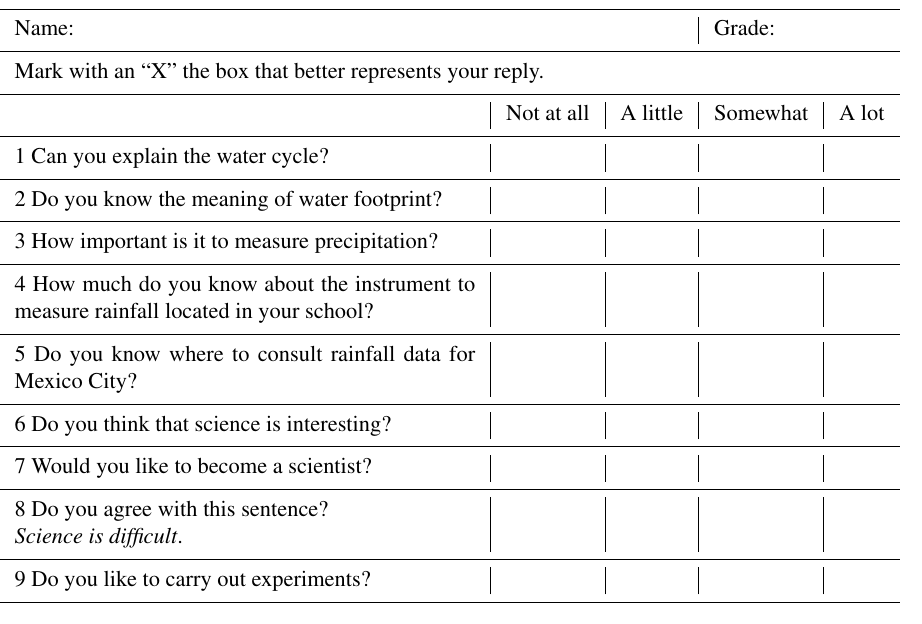
Table 2. Diagnostic evaluation questionnaire of learners’ perceptions to science, scientists, and basic concepts related to water